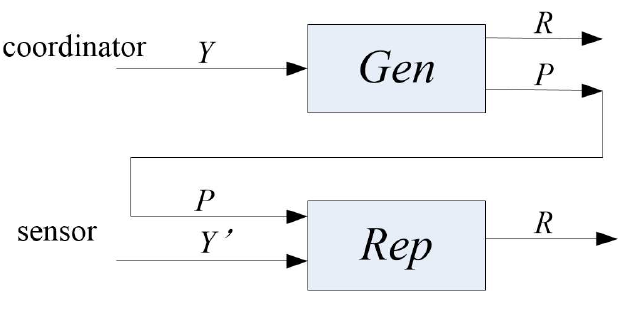
Figure 3. The fuzzy